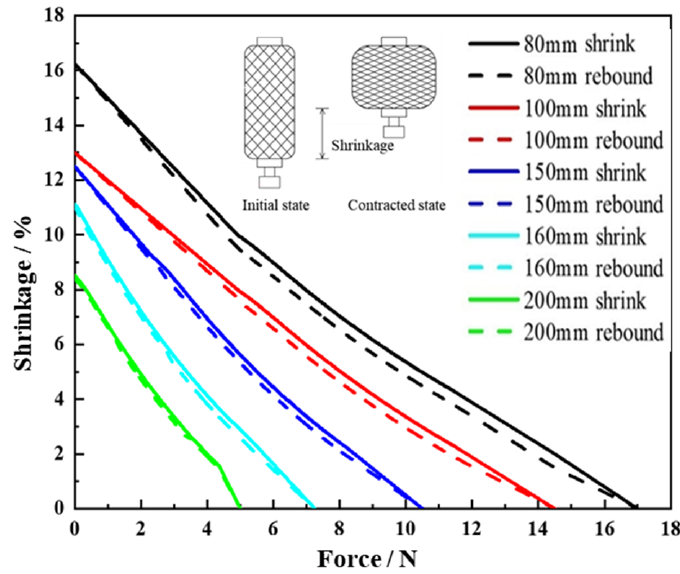
Figure 12. Load-stretching experiment of pneumatic muscle fibers.